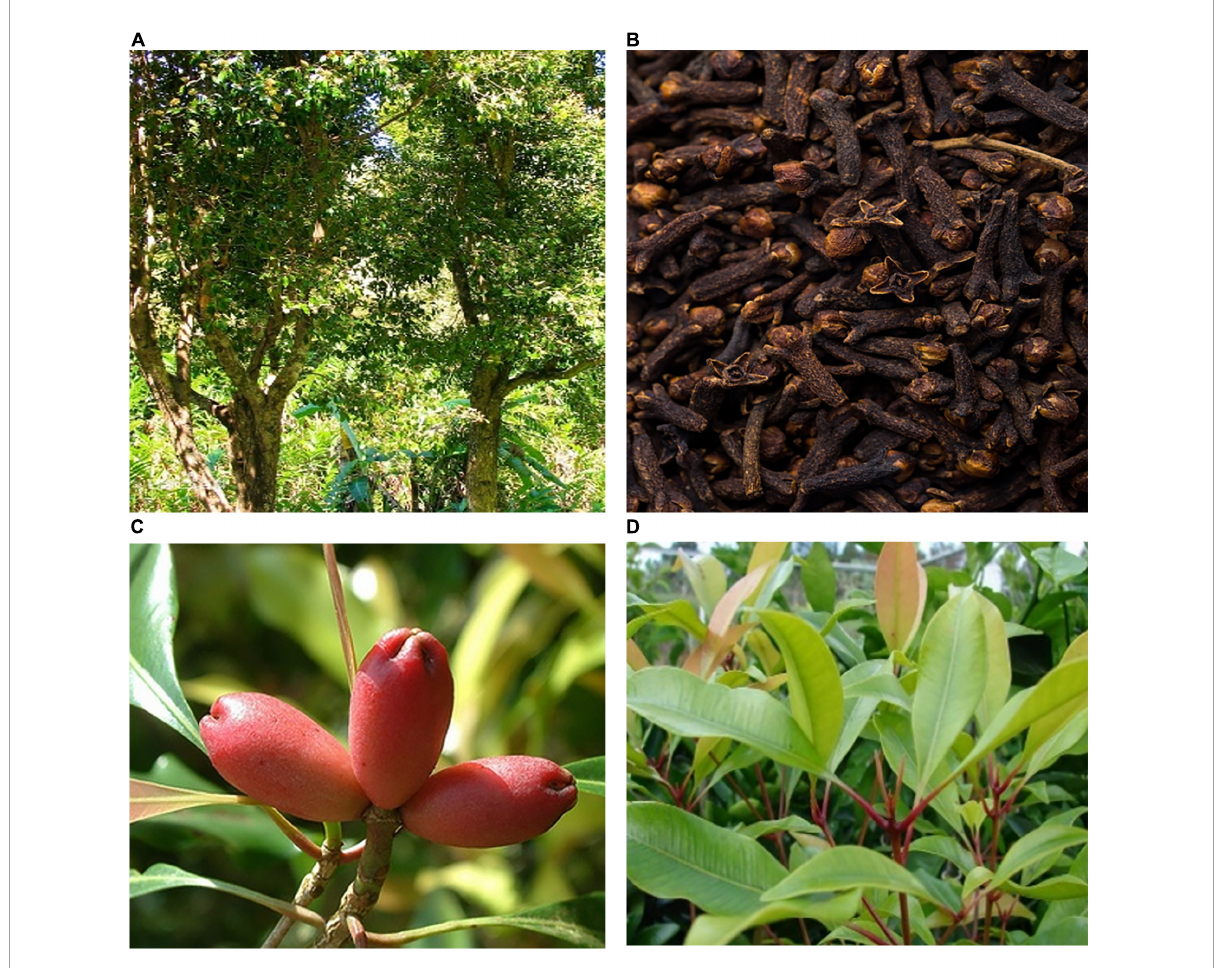
FIGURE2 Different parts of S. aromaticum . (A) Whole plant; (B) dried flower buds; (C) fruit; (D) leaf. Pictures are from https://baike.baidu.com/pic/%E4%B8%81%E5%AD%90%E9%A6%99/19435258.